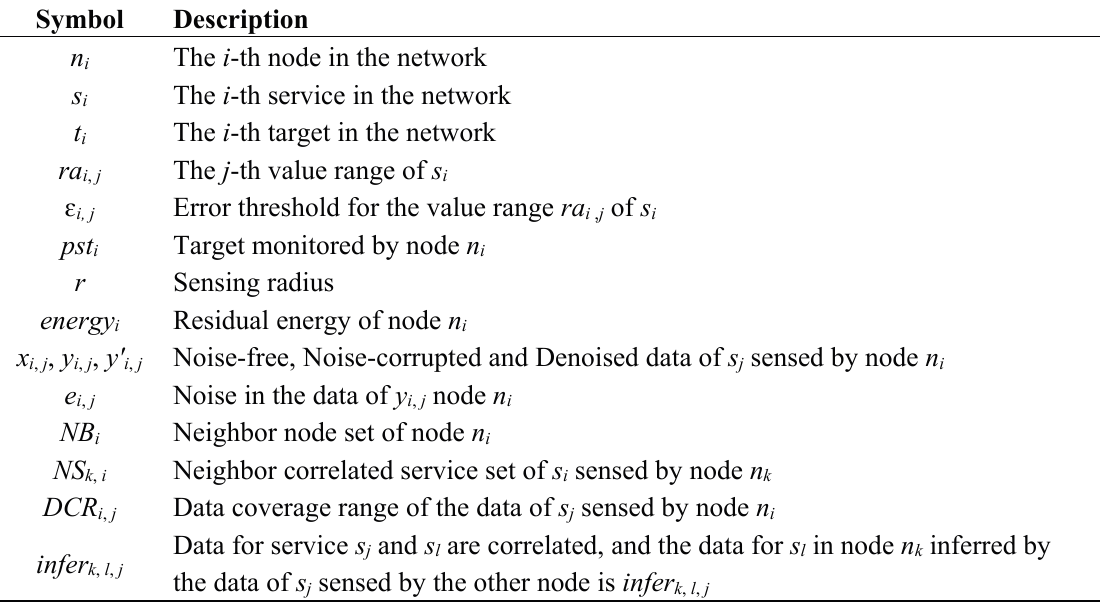
Table 1. Notation of the